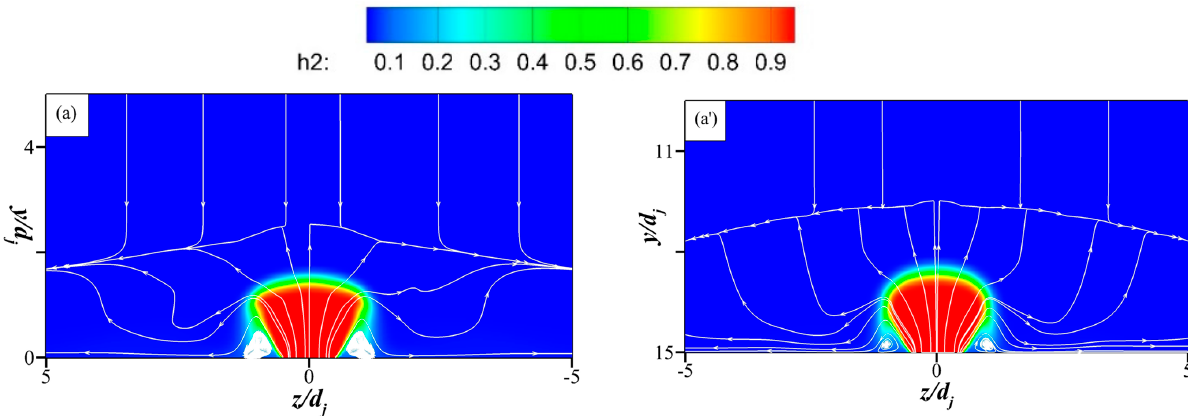
Figure 10. Flow field structure diagram of Case4. ( a ) Mach number contour. ( b ) Hydrogen mass fraction contour. ( c ) Diagram of